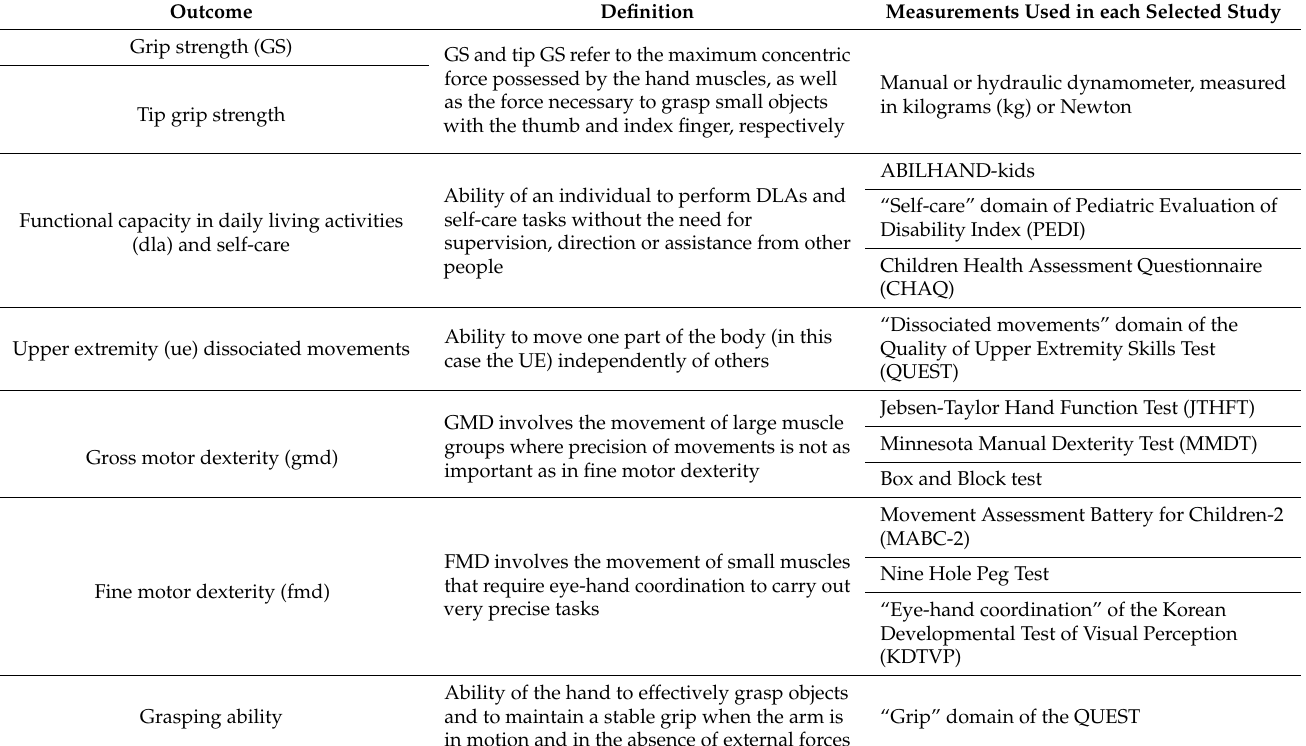
Table 2. Synthesis of the assessed outcomes and their measurements in studies included in the